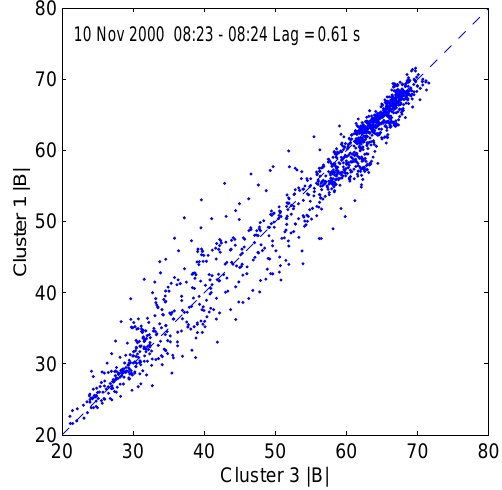
Fig. 7. Cross-correlation functions between the spacecraft pairs shown in Fig. 5: Cluster 1 and 3 (solid black trace), Cluster 4 and 3 (solid magenta trace), Cluster 4 and 1 (dotted magenta trace) and finally Cluster 2 and 3 (solid red trace).